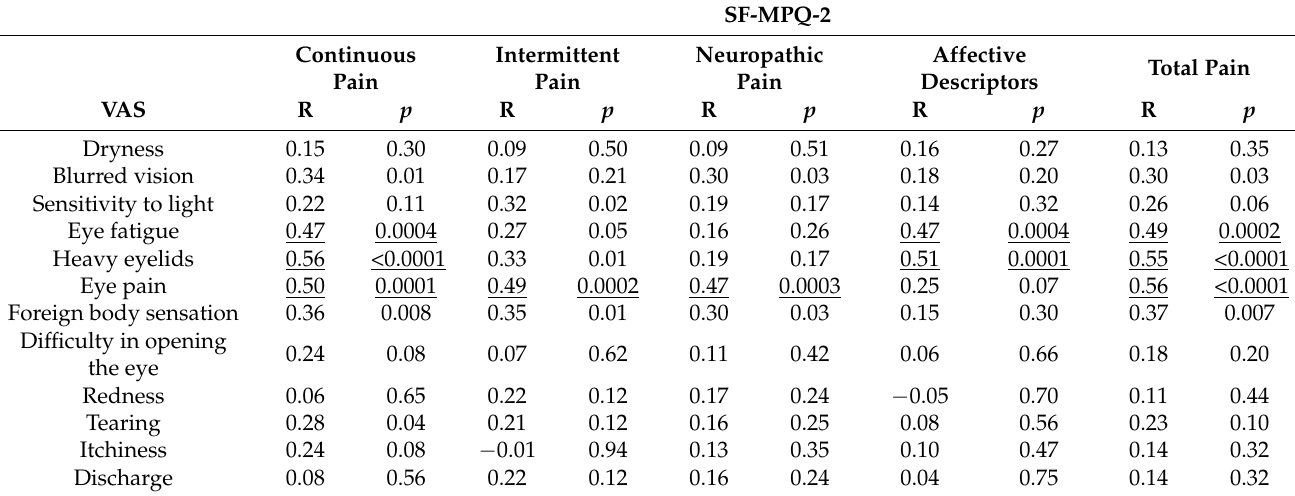
Table 2. Correlation between subjective symptoms of dry eye evaluated by VAS and SF-MPQ-2, evaluated by points.